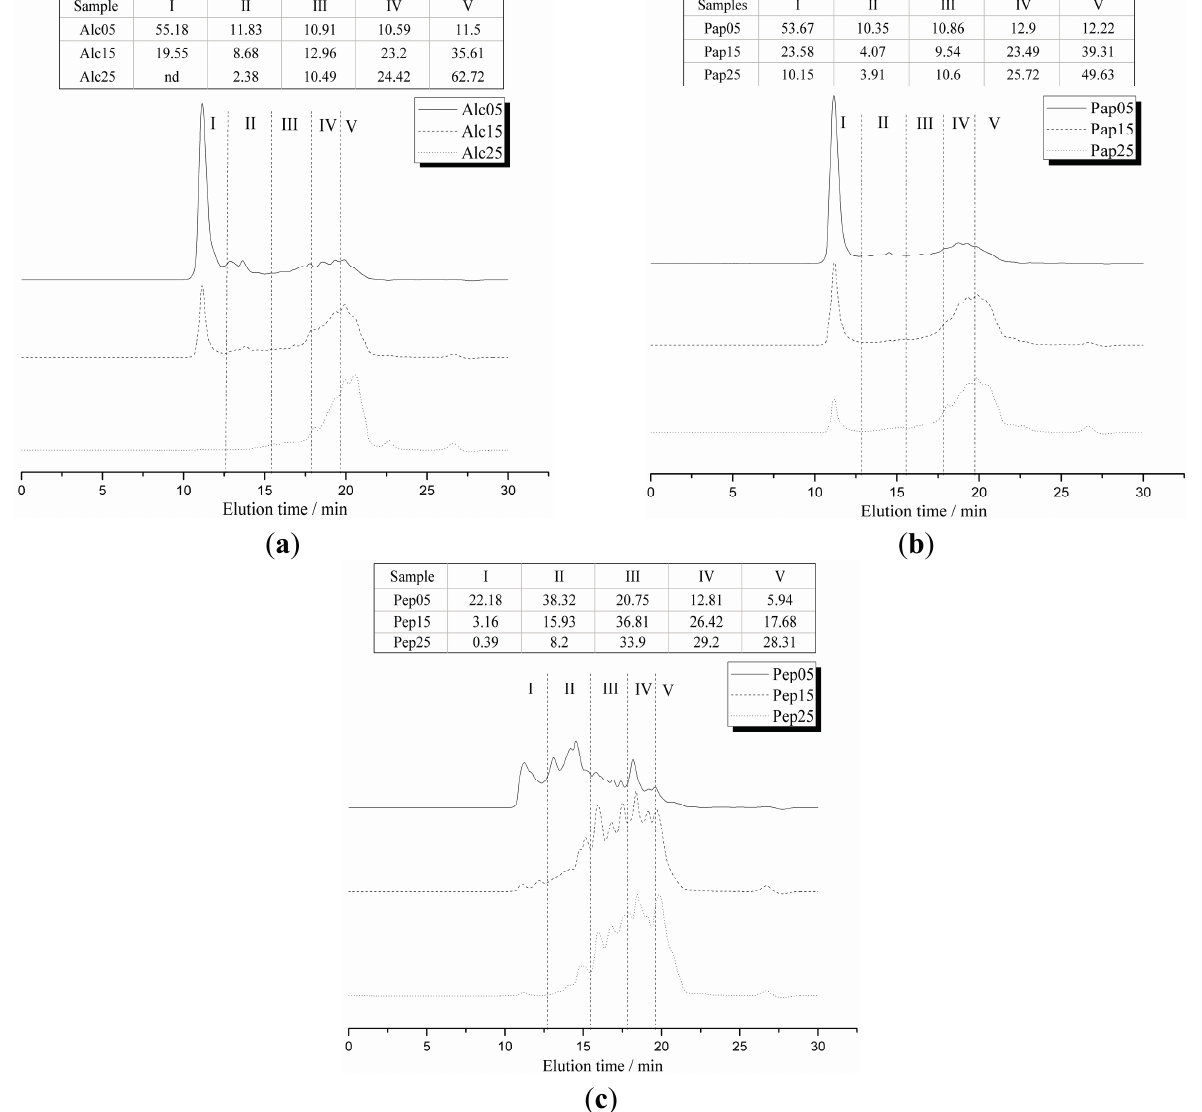
Figure 1. SEC-HPLC profiles of soy glycinin hydrolysates (SGHs) with different degree of hydrolysates (DH) obtained by enzymatic hydrolysis with alcalase ( a ), papain ( b ) and pepsin ( c ). The SEC-HPLC profiles are divided into 5 fractions. Inserted tables give the percentage of every fraction. Fraction I corresponds to protein fragments with molecular weight ( M w) exceeding 10 kDa, fraction II to protein fragments with M w between 3 and 10 kDa, fraction III to protein fragments with M w between 1 and 3 kDa, fraction IV to protein fragments with M w between 0.5 and 1 kDa and fraction V to material with M w lower than 0.5 kDa. Sample codes consist of 3 letters encoding the enzyme and 2 digits encoding the